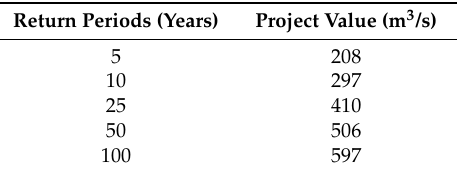
Table 1. Flood hydrograph peak values.